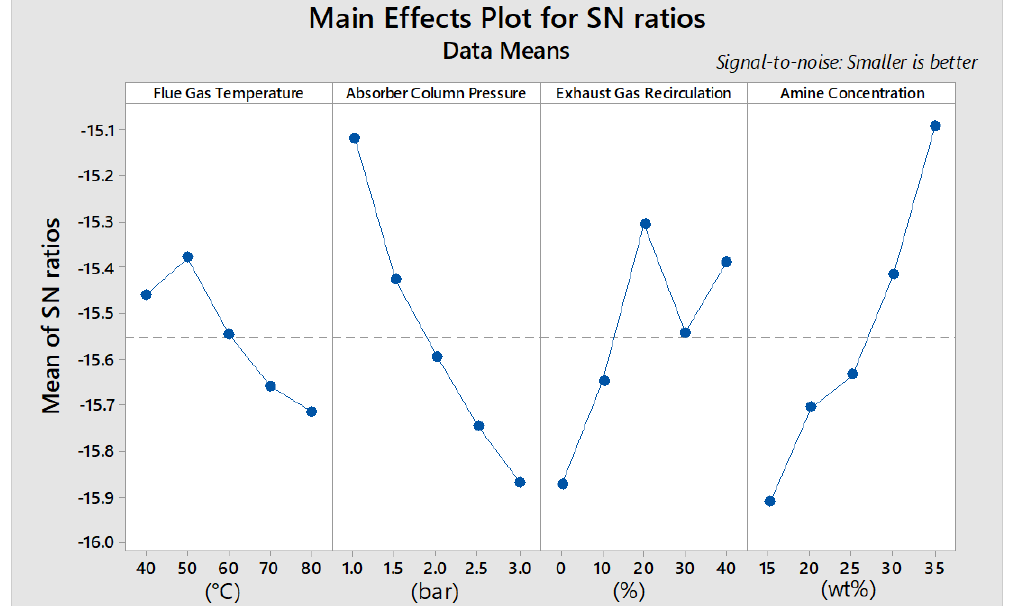
Figure 4. The main effects plot for the SNR.